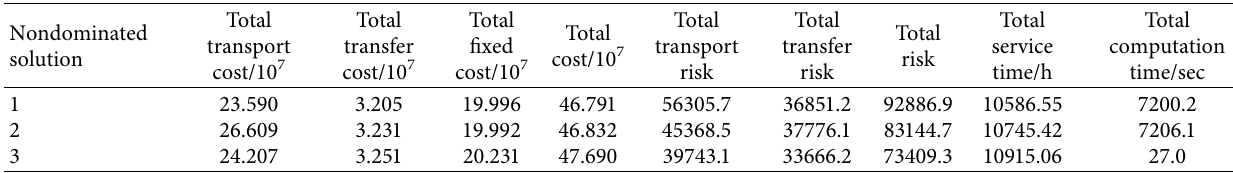
Table 4: Summary results of representative nondominated